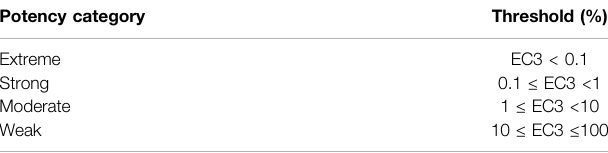
TABLE 3 | The skin sensitization potency based on LLNA EC3 values. Potency category